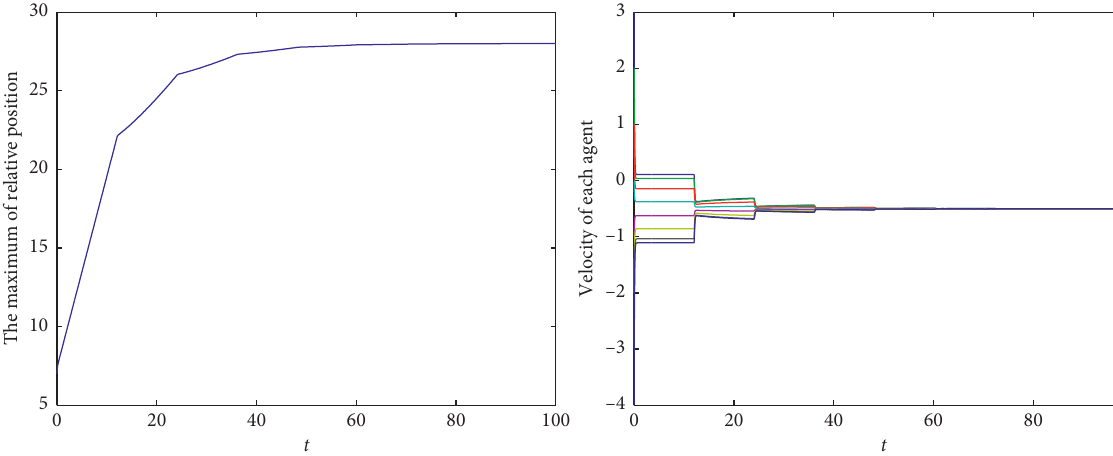
Figure 4: α � 15 , β � 0 . 2 < 0 . 5 , τ � 12. Systems (3) and (4) form a flock